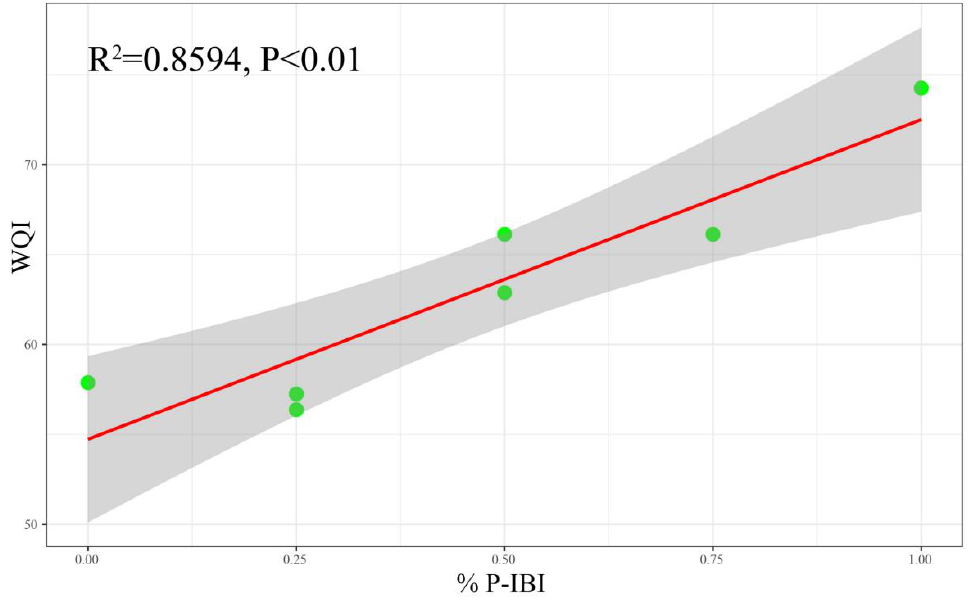
Figure 8. Linear regression between WQI and % P – IBI across sampling sites. % P – IBI indicates the percentage of sampling sites with P – IBI evaluation results exceeding the “moderate” level.